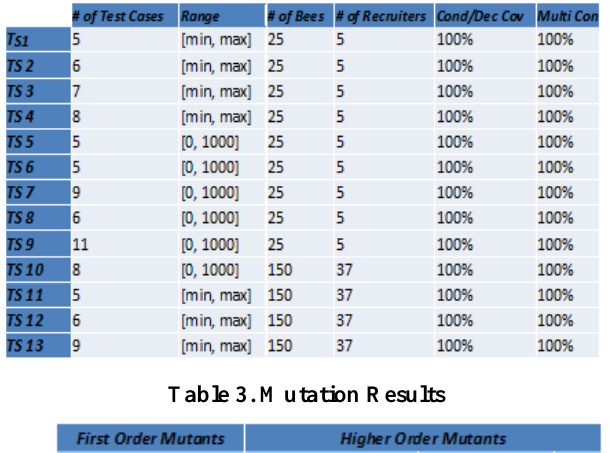
Table 2. Summary of the test suites used